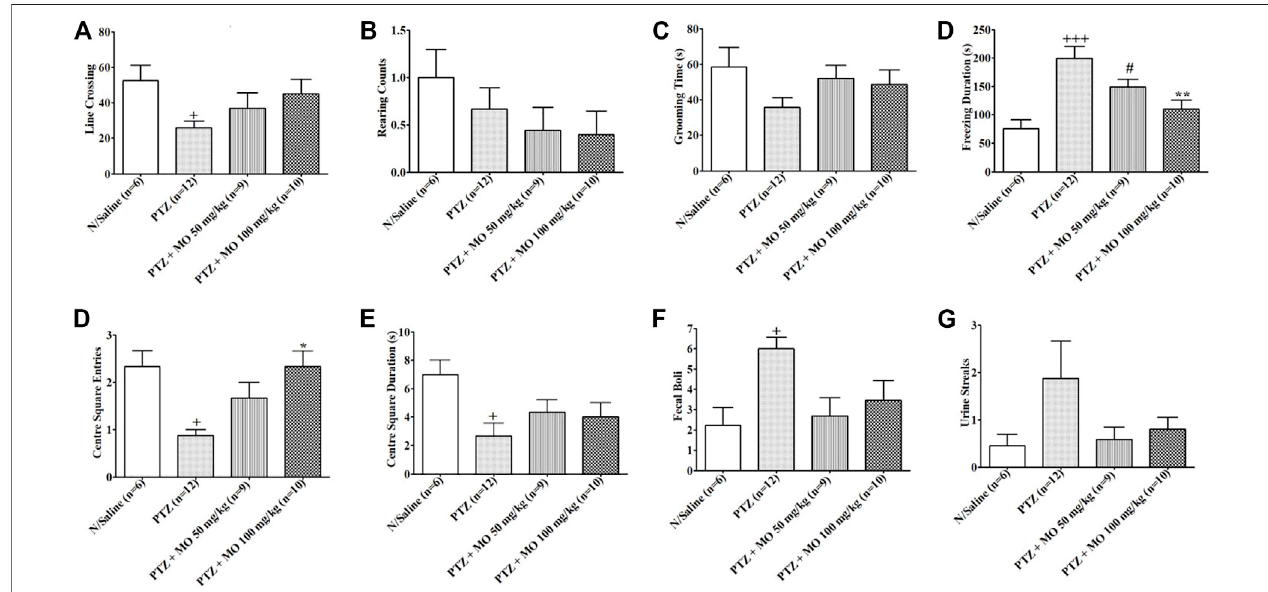
FIGURE5| Effectsof Melissaof fi cinalis L.essentialoil(MO)onperformanceinopen fi eldtestinPTZ-kindledrats. (A) Linecrossing,+ p < 0.05(N/SalinevsPTZ); (B) Rearing counts; (C) Grooming time; (D) Freezing duration, +++ p < 0.001 (N/Saline vs PTZ), # p < 0.05 (N/Saline vs PTZ + MO 50 mg/kg), ** p < 0.01 (PTZ vs PTZ + MO 100 mg/kg); (E) Centresquareentries,+ p < 0.05(N/SalinevsPTZ),* p < 0.05(PTZvsPTZ+MO100 mg/kg); (F) Centresquareduration,+ p < 0.05(N/SalinevsPTZ); (G) Defecation, + p < 0.05 (N/Saline vs PTZ); (H) Urination. n (cid:2) number of animals tested. Mean ± SEM.